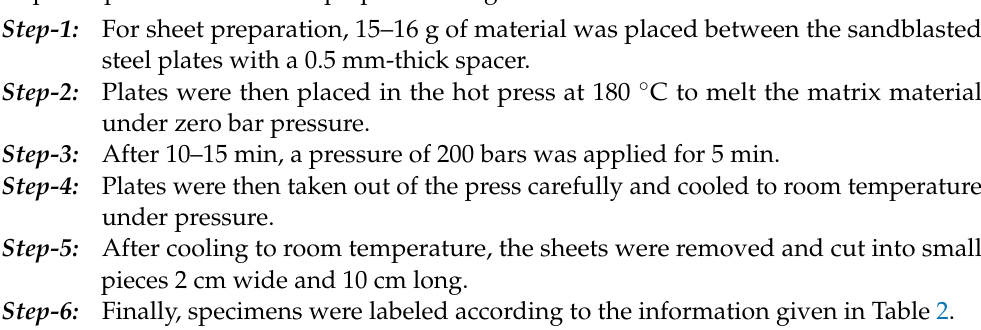
Table 2. Representation of sample codes with filler concentration. Sample